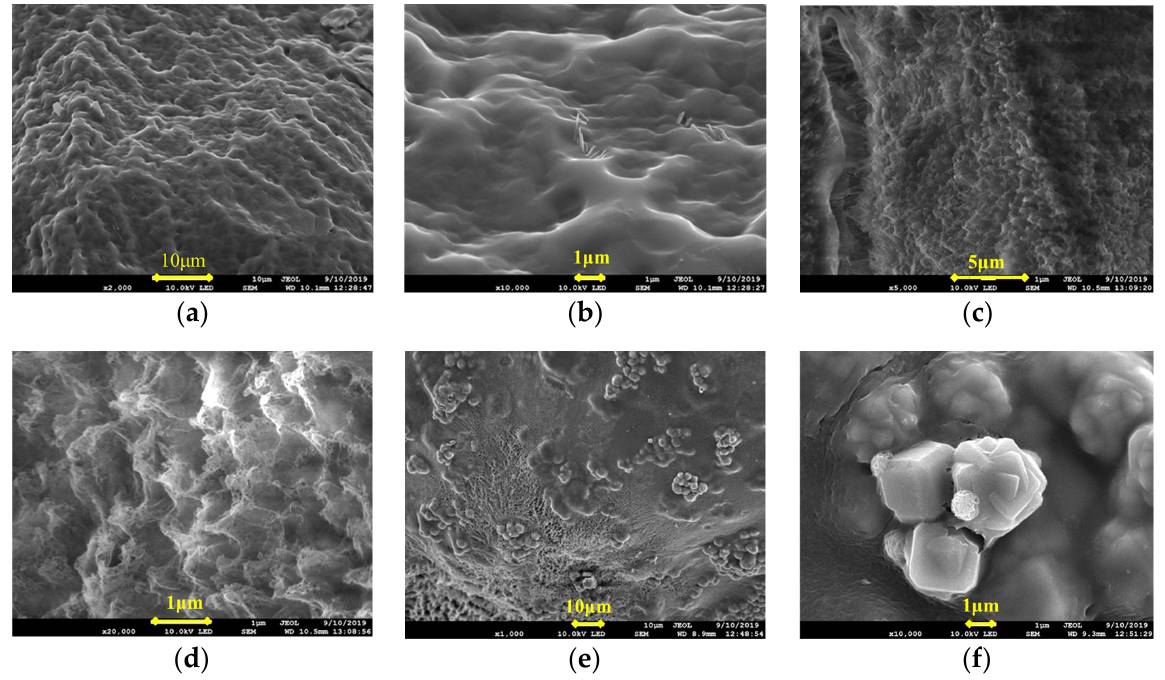
Figure 3. SEM Images of ( a ) @sericite, ×2000; ( b ) @sericite, ×10,000; ( c ) @lithium saponite, ×5000; ( d ) @lithium saponite, ×20,000; ( e ) @ zeolite powder, ×1000; and ( f ) @ zeolite powder, ×10,000.